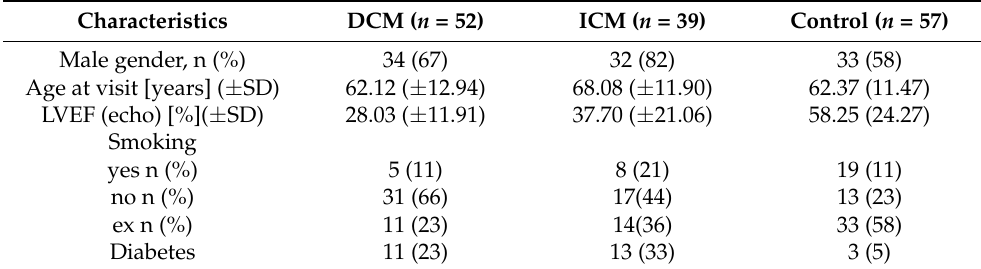
Table 2. Patient characteristics of the stage 2